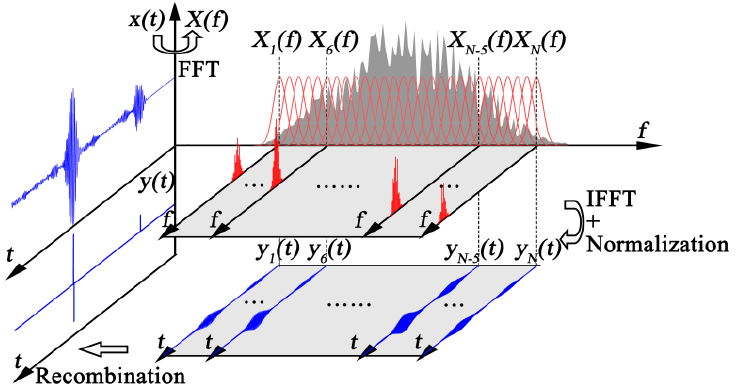
Figure 3. Schematic diagram of SSP.